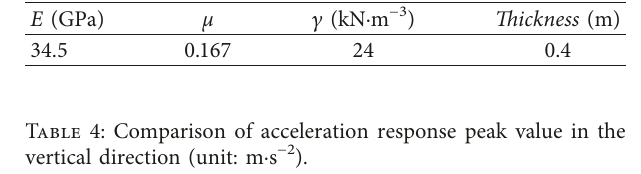
Numerical simulation